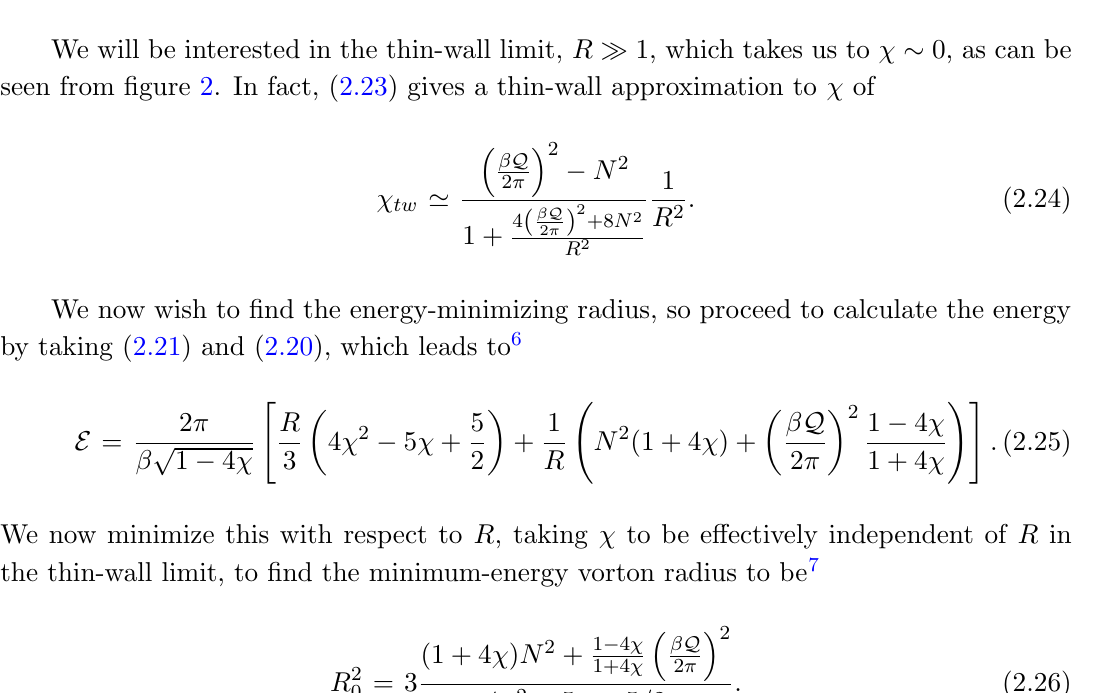
Figure 2 . A plot showing how R varies with (cid:31) , for N = 200 (left), 150, (cid:12) Q the case 2 (cid:12) Q = 1500, in units where (cid:12)(cid:17) 2